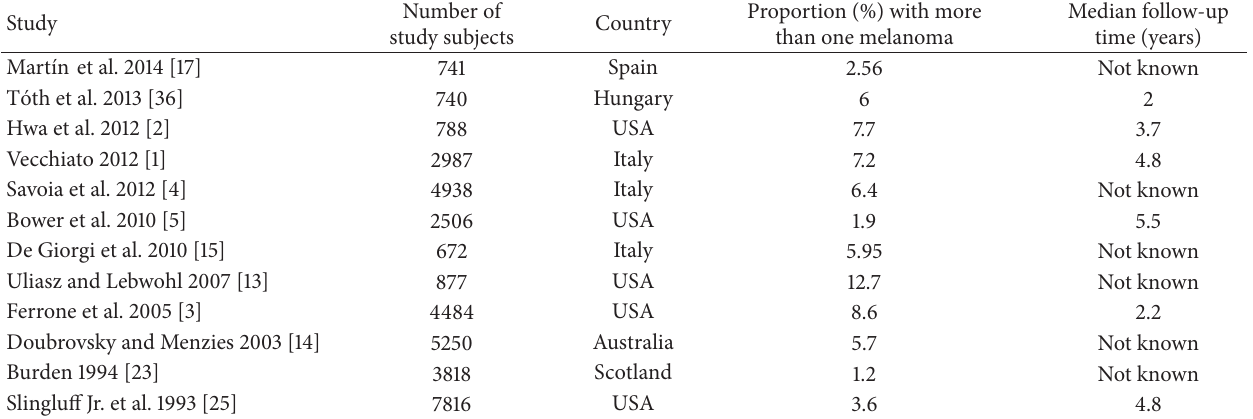
Table 2: Studies with more than one melanoma.